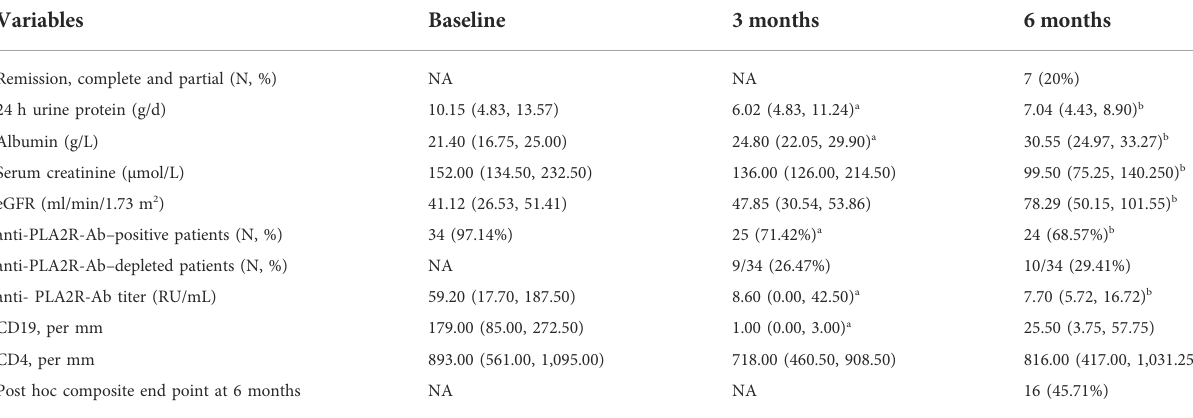
TABLE 2 Ef fi cacy outcome